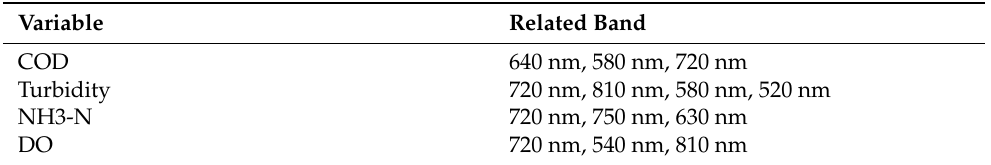
Table 4. Several bands most related to four water quality parameters (sorted in descending order of